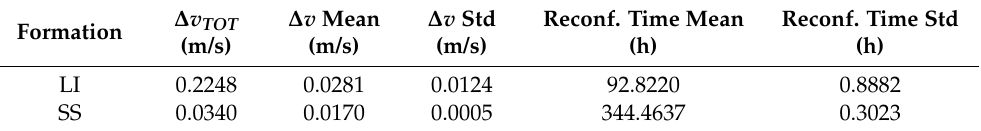
Table 3. Maneuvering frequency and ∆ v required for maintenance of safety tube-based formations over the first 6 months of mission— h = 550 km, no navigation errors. Formation